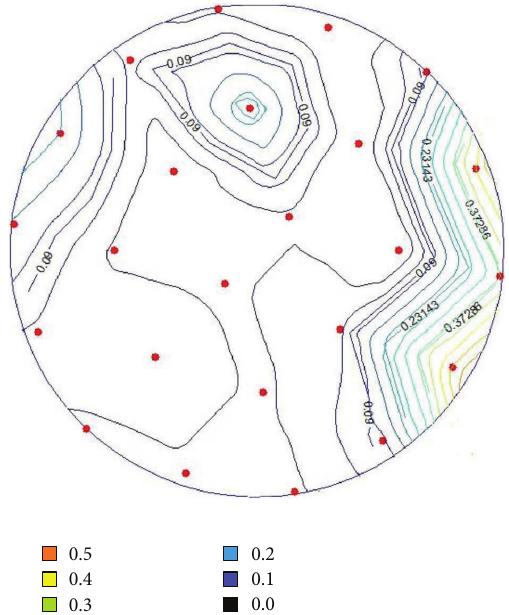
Figure9:Themainresultsofthedynamicsubreflector.Thedynamic subreflector was able to improve the overall antenna gain in about 5 dB which is shown at 14.5 Ghz; this even improves the original antenna performance in about 1dB gain. The improvement is valid for about 𝜔 = 330 Mhz frequency-band, ranging from 14.33 to 14.66 Ghz.